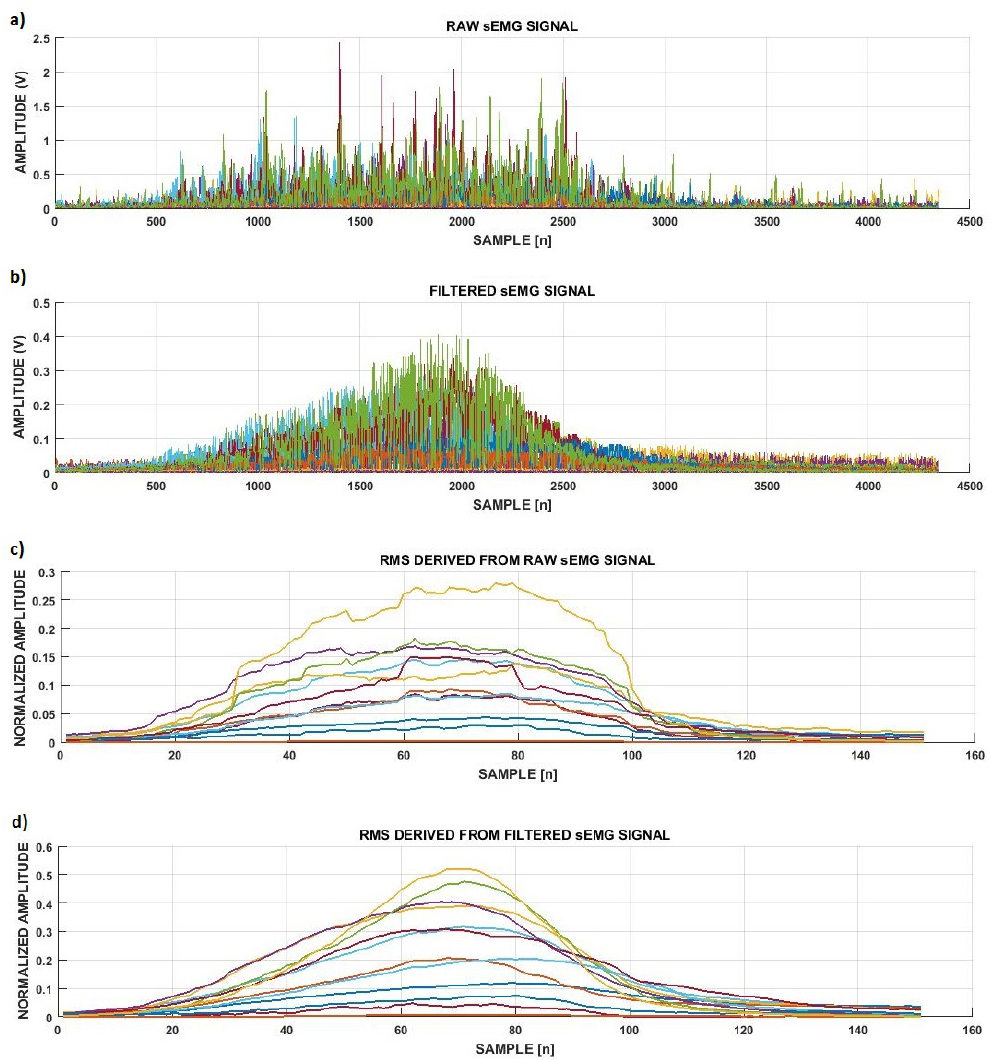
Figure 4. Effect of the AVT filter on the channels of the raw rectified sEMG signal and RMS feature for a movement repetition performed: ( a ) raw rectified sEMG signals; ( b ) the same portion of sEMG signals filtered; ( c ) RMS feature extracted from the signals presented in ( a ); ( d ) RMS feature extracted from the signals presented in ( b